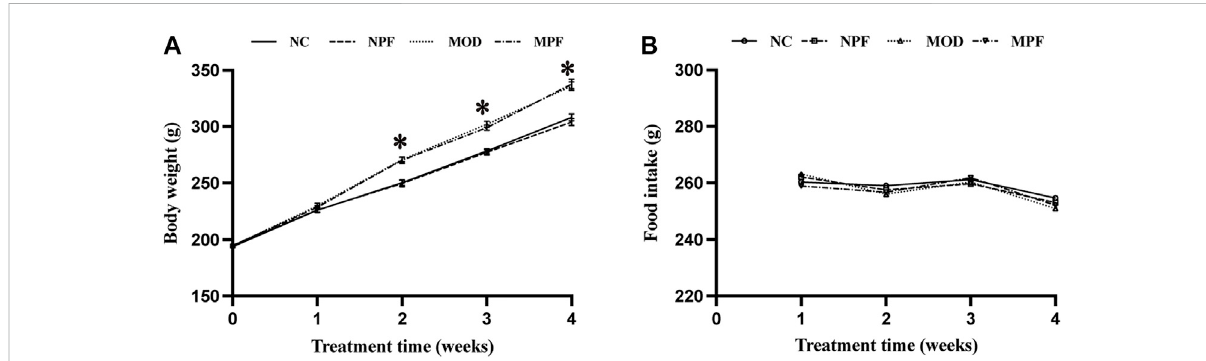
Effectsofpaeoni fl orin(PF)onbodyweight,andfoodintake. (A) WeightchangesforratsinthefourgroupsduringthetreatmentwithPF. (B) Food intake of each rat in the four groups during the treatment with PF. The liver samples were obtained from the normal control group (NC),